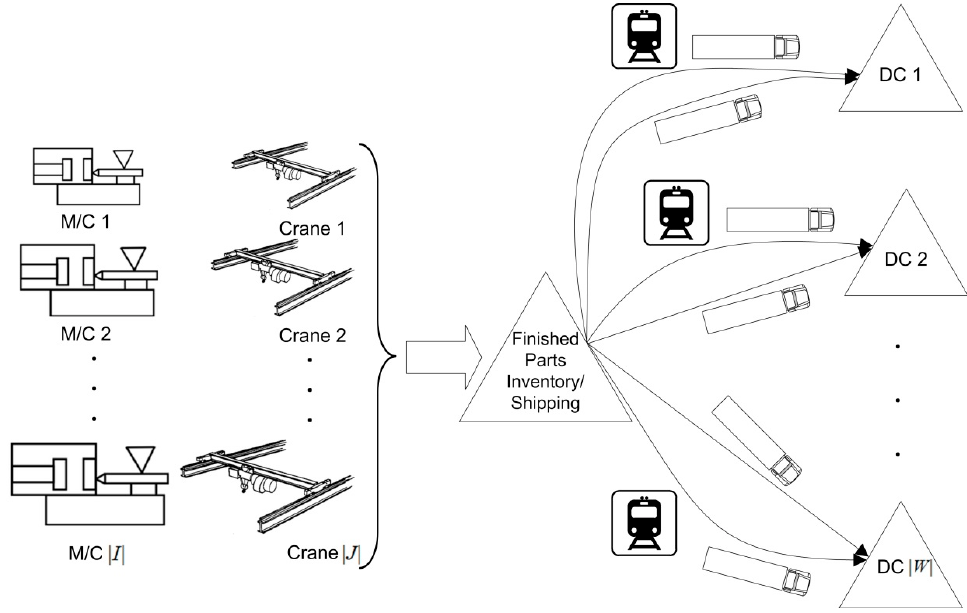
Figure 1. The two-stage automotive supply chain system with heterogeneous transportation.